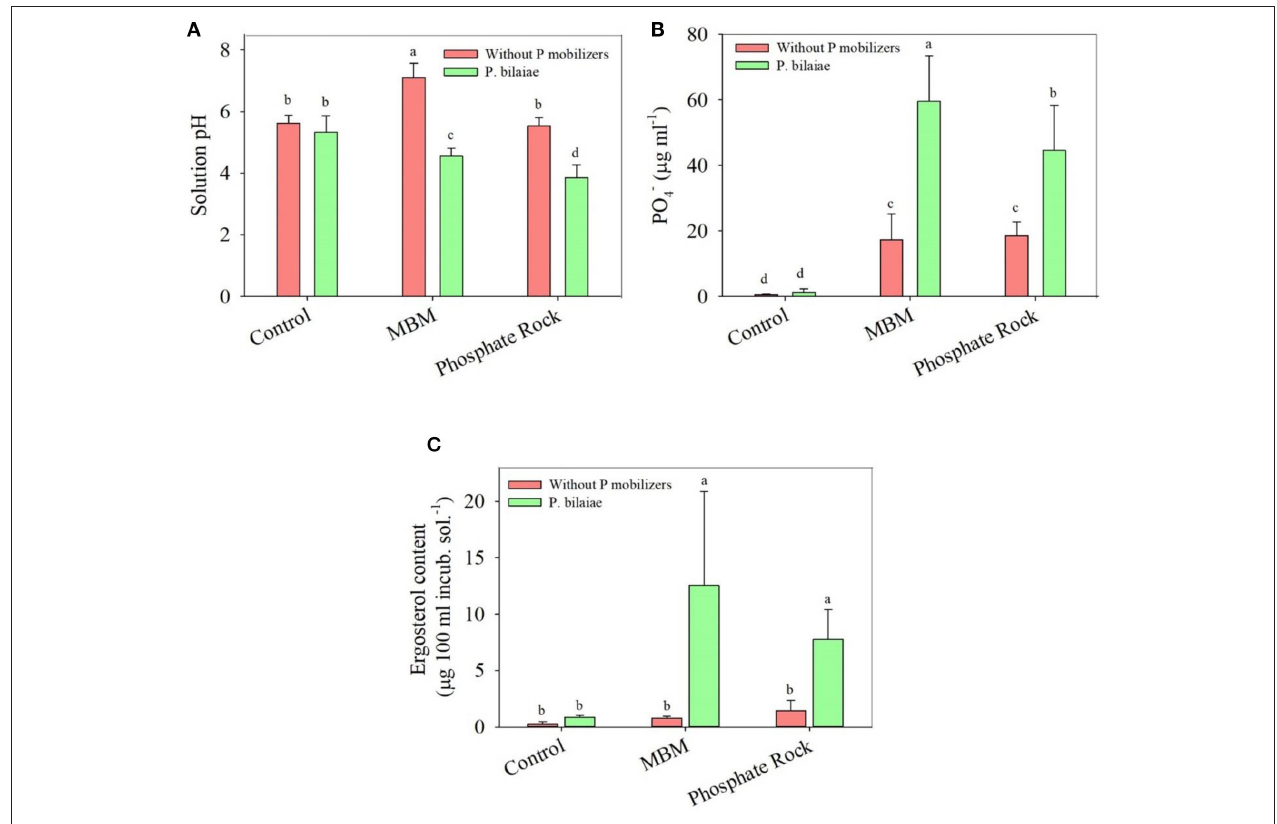
FIGURE 2 | Solution pH (A) , PO 4 − (B) , and ergosterol (C) content as affected by different P fertilizers and P. bilaiae at 7 days after incubation. Different alphabetical letters signify the statistical difference (Tukey test, p < 0.05) across the treatments. Error bar represents the mean ± SD ( n =